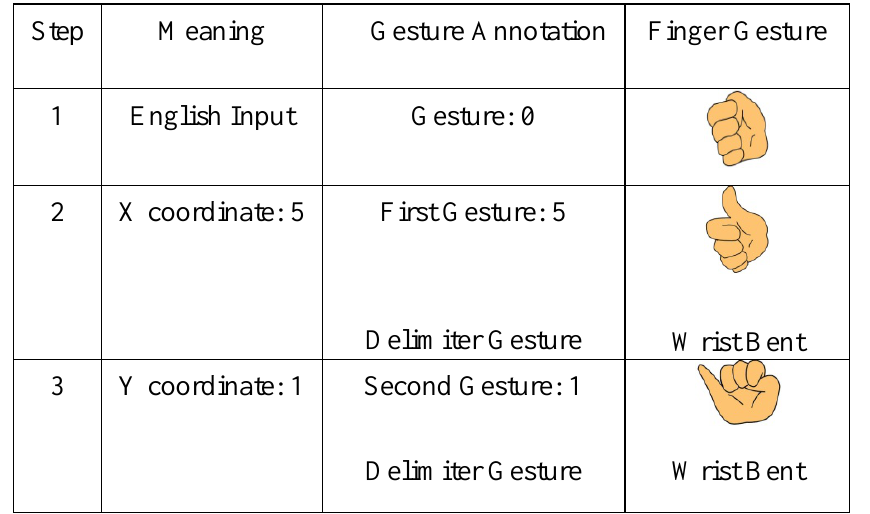
Table 4. Exemplified input sequence for letter E (containing 3 steps/5